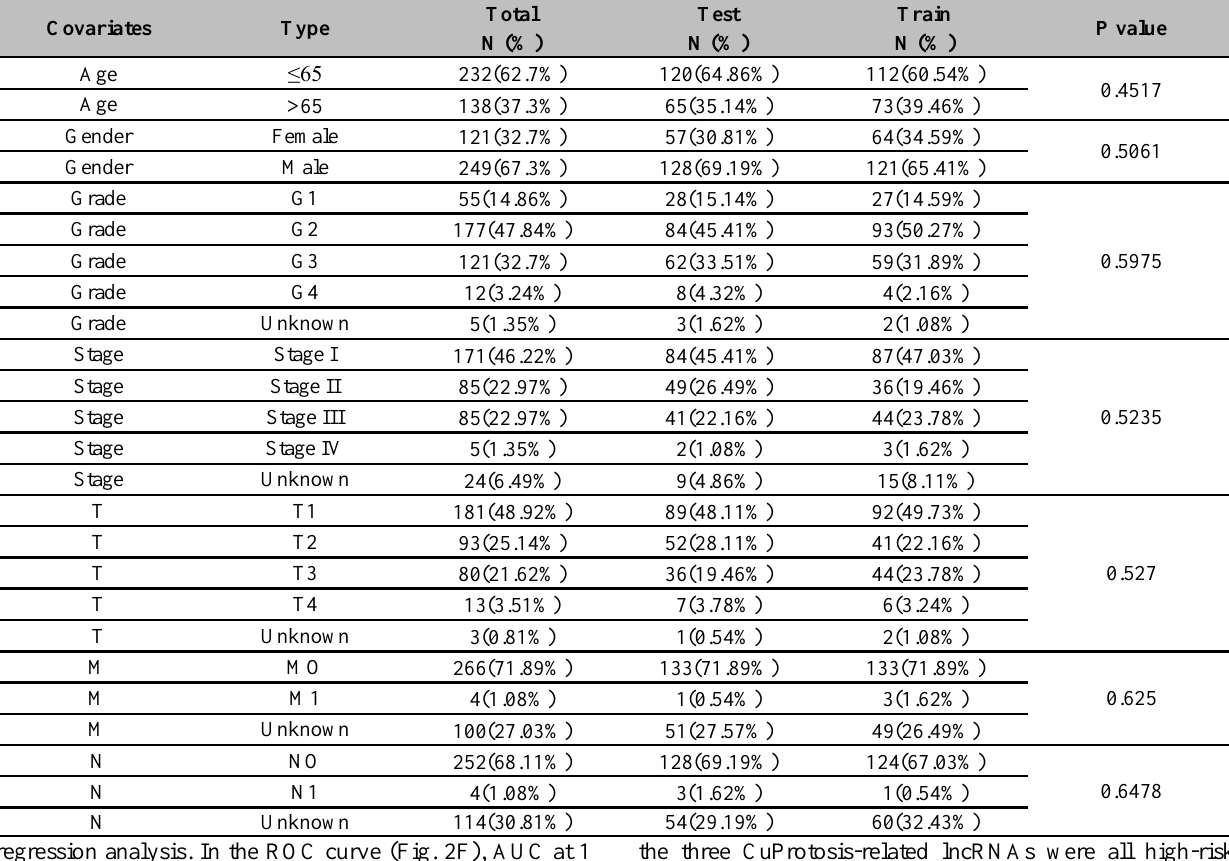
Table 1: Comparison of clinical characteristics of liver cancer patients between train and test groups